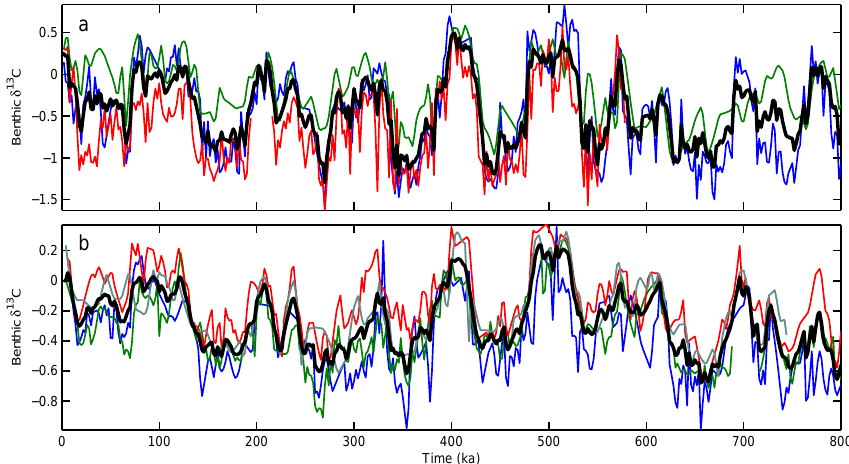
Fig. 1. Component records for (a) the SCW δ 13 C stack (black): ODP 1090 (blue), ODP 1089 (red), and GeoB1211 (green) and (b) the PDW δ 13 C stack (black): ODP 677 (blue), ODP 806 (gray), ODP 846 (green), and ODP 849 (red). See Table 1 for